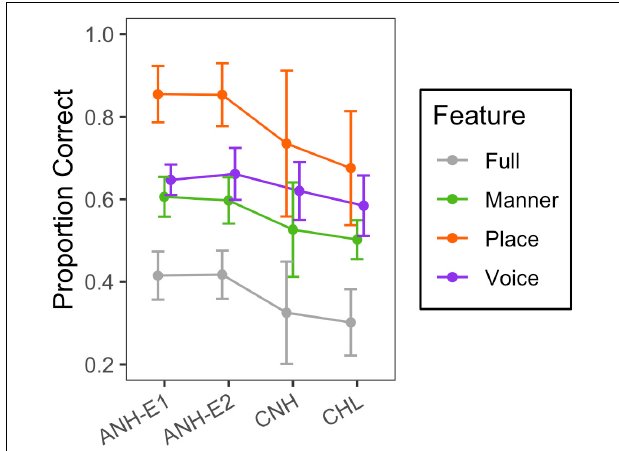
FIGURE 7 | Mean and standard deviation of scores for the visual-only condition. Group is indicated on the horizontal axis, and phonetic feature is indicated with color, as defined in the